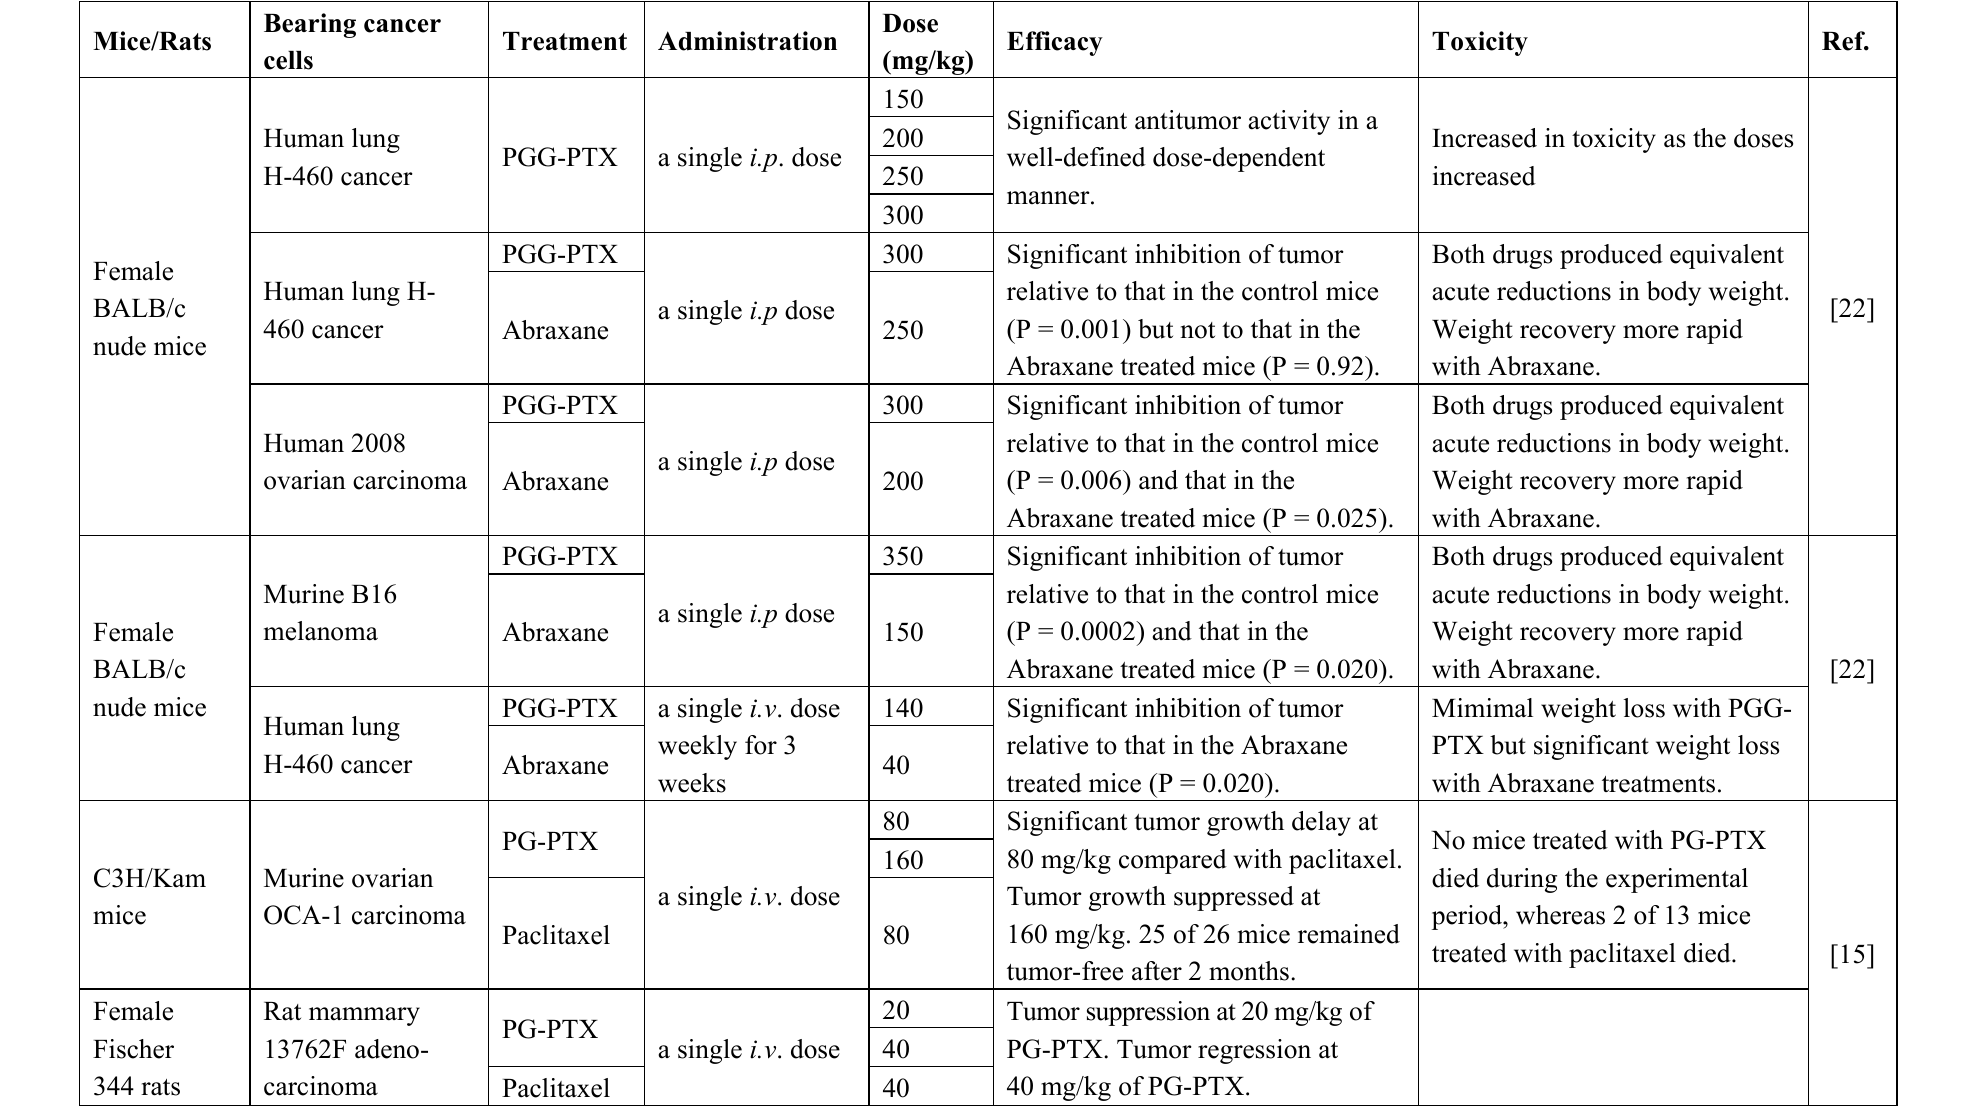
Table 2. Results of in vivo efficacy of polymer-paclitaxel